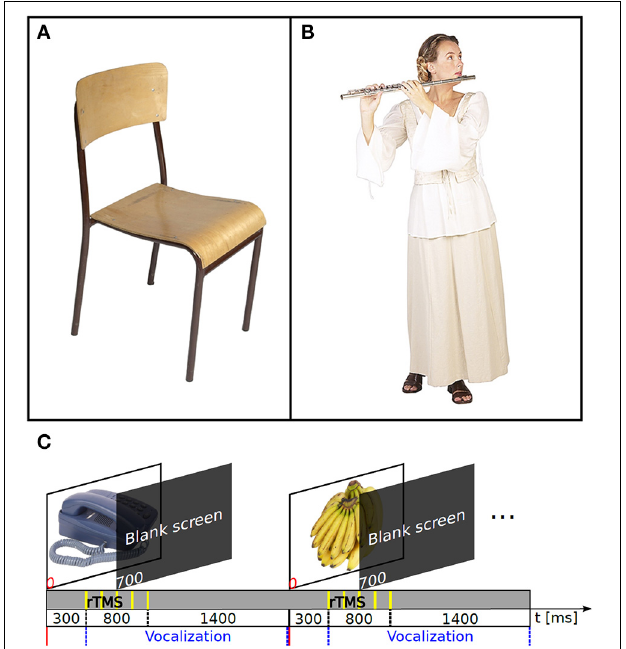
FIGURE 1 | The nTMS speech mapping method. An example of images used in object (A) and action naming (B) . (C) Timeline of the events in the nTMS speech mapping. The interpicture interval was